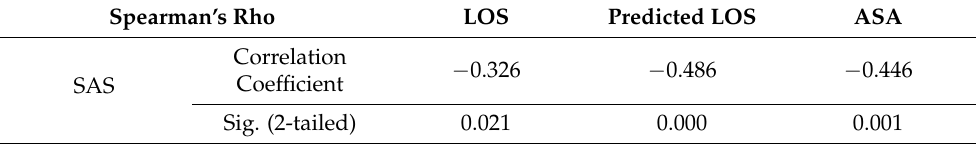
Table 4. Negative correlation between predicted LOS, real LOS, ASA class, and